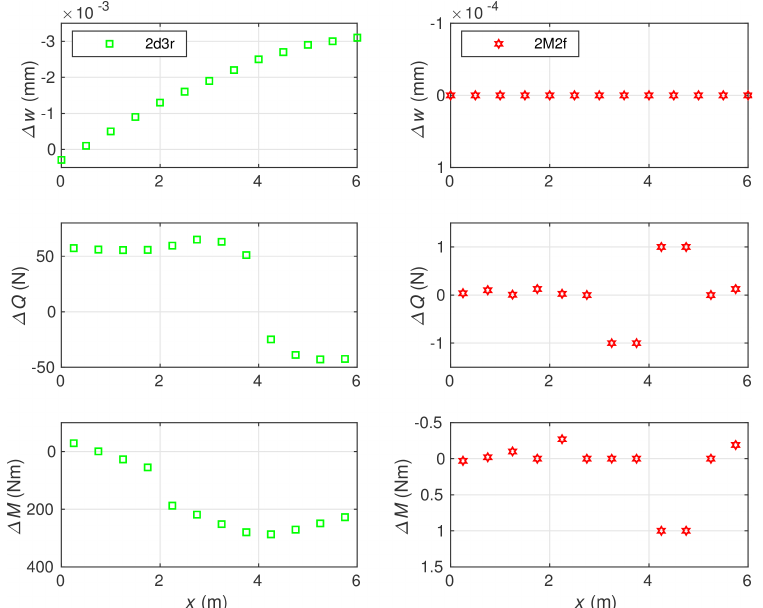
Figure 15. Comparison of errors for the deflections, shear forces and bending moments obtained with 12 element meshes: for 2d3r ( left diagrams ) and 2M2f ( right diagrams ). K s = 0.2 · 10 9 N.